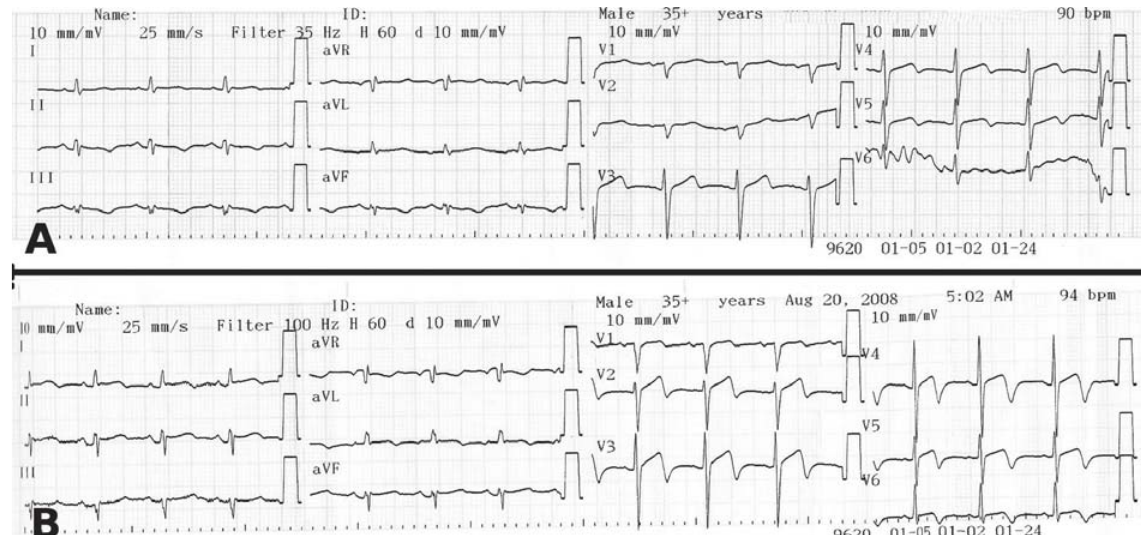
(B)Fig. 3 - Eletrocardiograma no POI (A). Alteração de repolarização inespecífica na parede anterior. Eletrocardiograma no 1 o PO (B). Supradesnivelamento do segmento ST de 1 mm nas derivações de V2 -